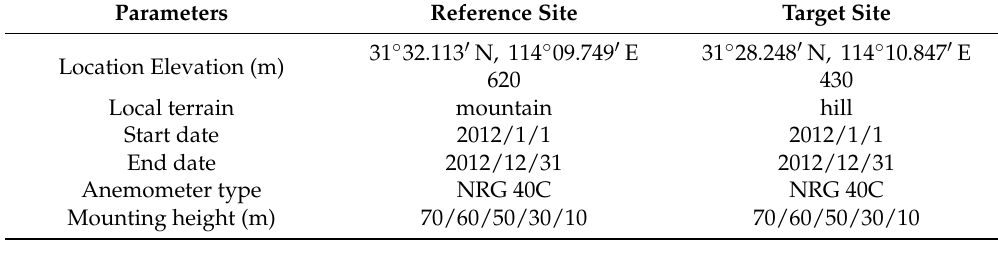
Table 5. Description of the two meteorological sites.